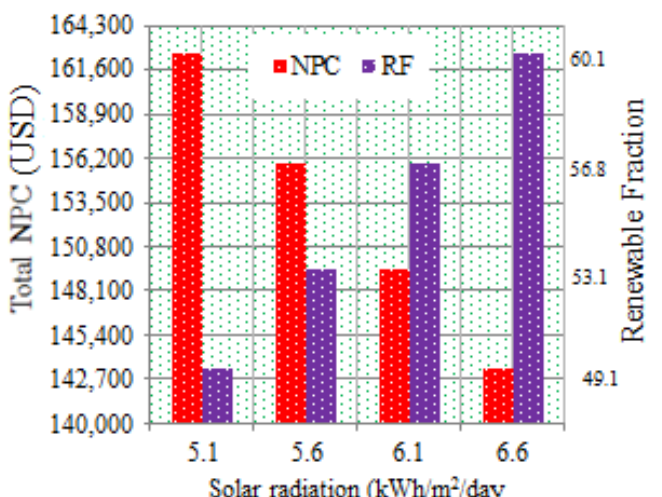
Figure 16. Impact of solar irradiance change on the NPC and RF.